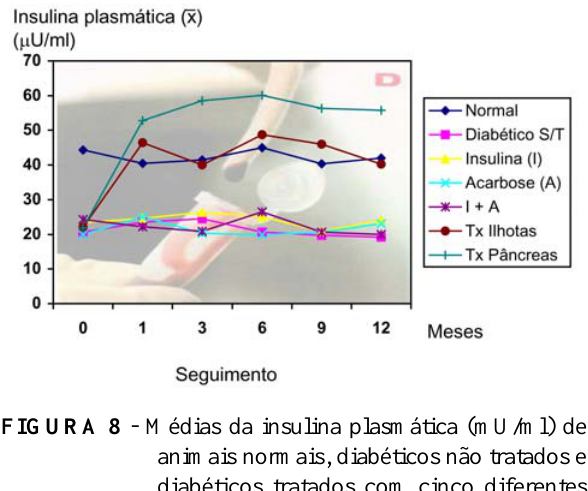
FIGURA 8 - Médias da insulina plasmática (mU/ml) de animais normais, diabéticos não tratados e diabéticos tratados com cinco diferentes tratamentos, durante 12 meses de